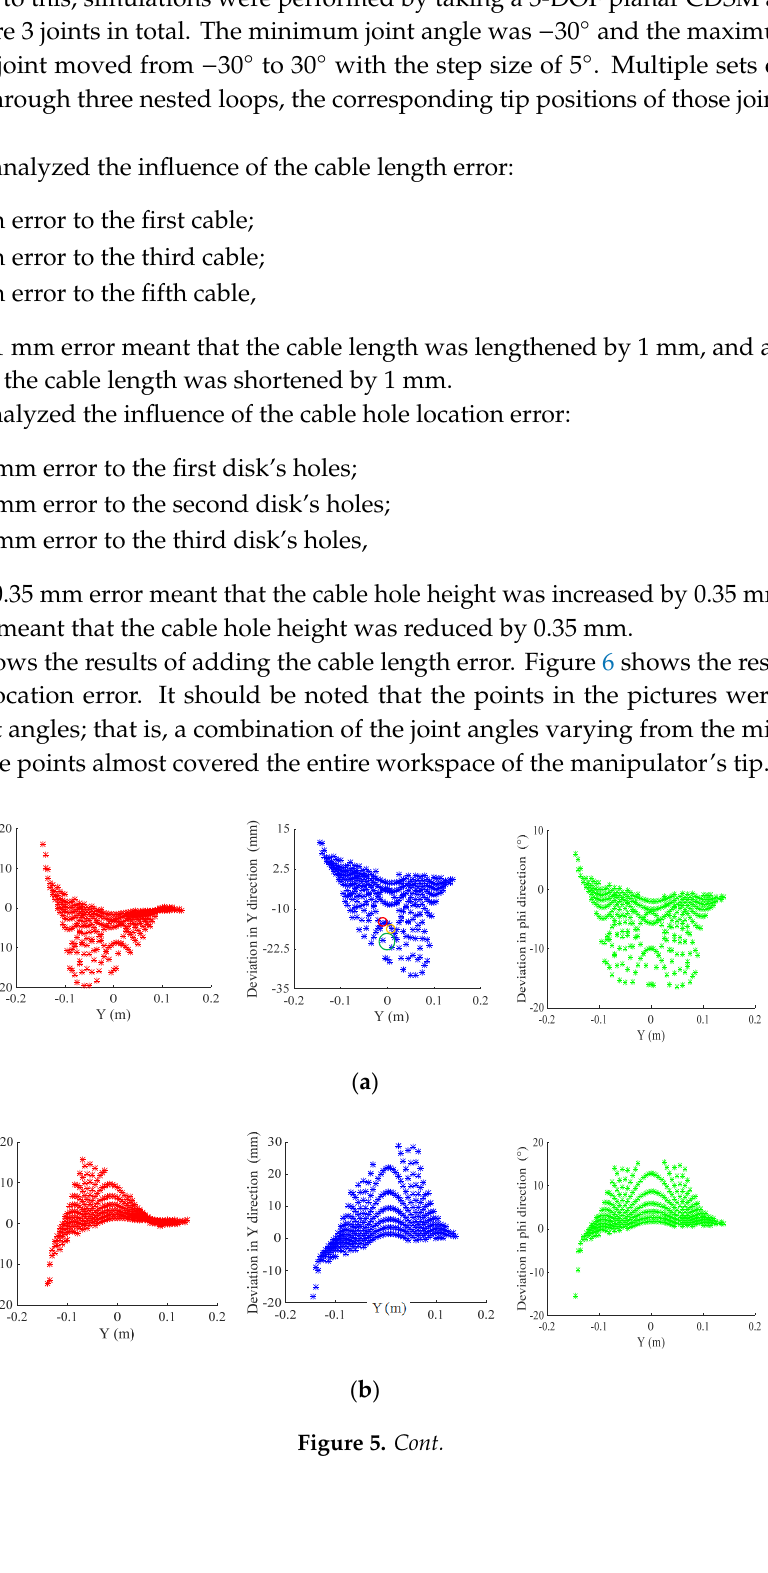
Table 1. Structure parameters of the 3-DOF planar CDSM.